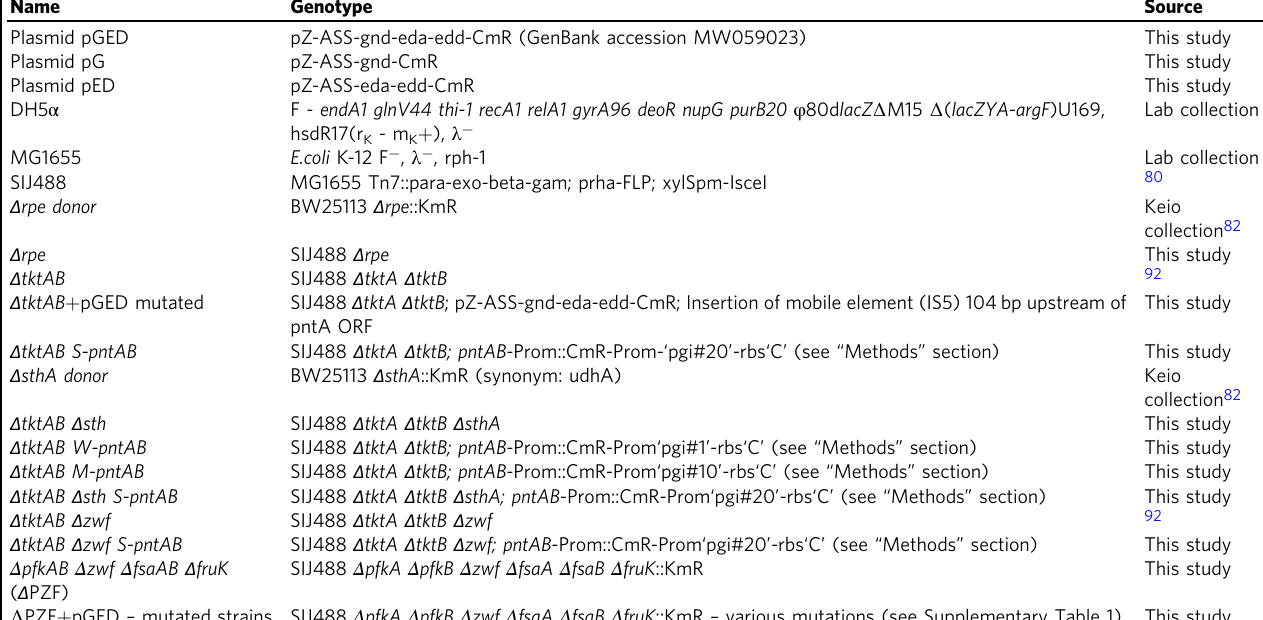
Table 2 List of strains and expression plasmids used in this